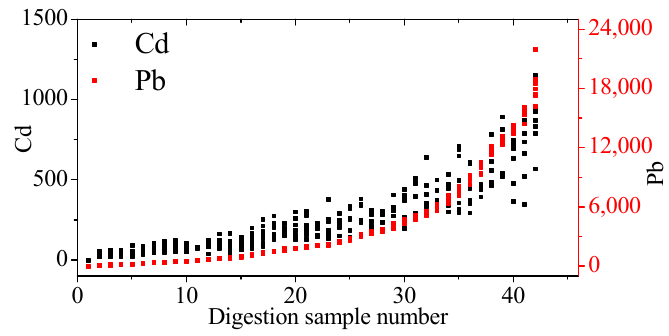
Figure 6. Samples divided into 42 groups according to intensity of Pb.